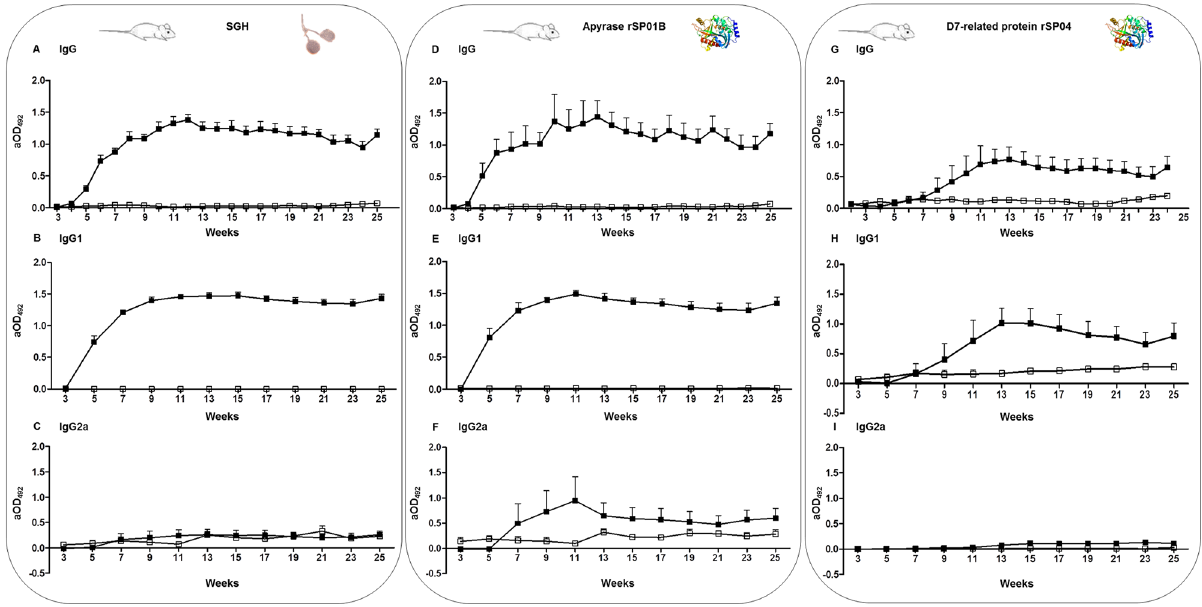
Fig 3. Humoral responses against P . perniciosus salivary gland homogenate and recombinant salivary proteins detected in sera of mice. (A), (B), (C) IgG, IgG1 and IgG2a antibody levels against P . perniciosus SGH. (D), (E), (F) IgG, IgG1 and IgG2a antibody levels against the recombinant apyrase rSP01B. G, H, I) IgG, IgG1 and IgG2a antibody levels against the recombinant D7-related protein rSP04. Open circles symbolize the non-exposed mice group while closed circles indicate the immunized mice group. Bars represent the geometric means. Antibody levels are expressed as adjusted optical density measured at 492 nm (aOD 492 ).